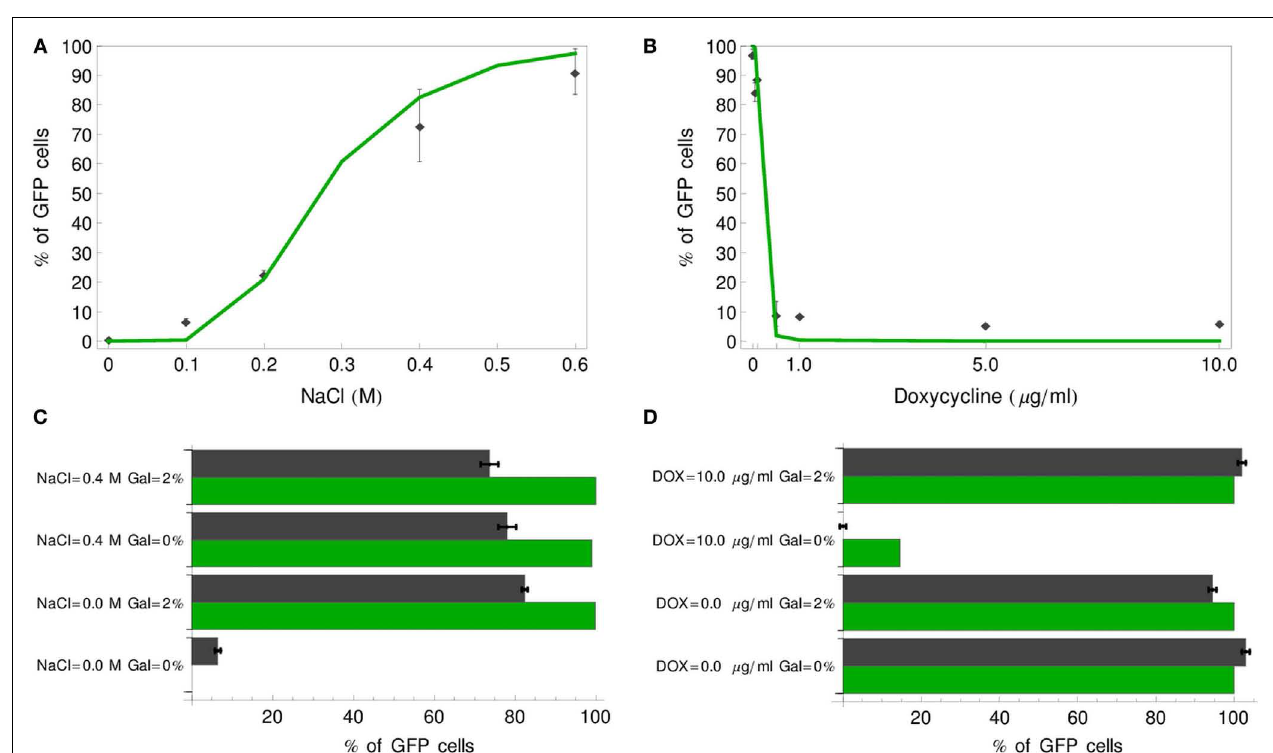
results (black diamonds). For the OR (C) and IMPLIES (D) gates four input concentration combinations were tested and the simulation results are plotted as green bars, whereas black bars correspond to the experimental data.